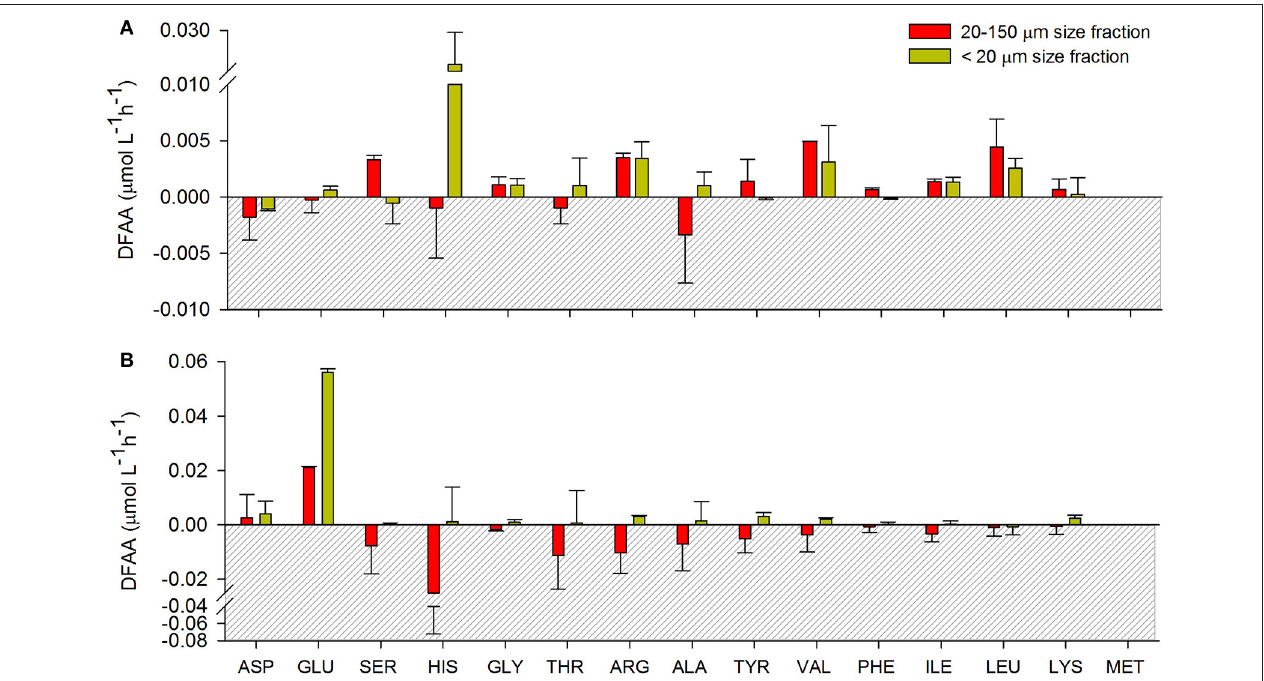
FIGURE 2 | Excretion rates obtained for aspartic acid (ASP), glutamic acid (GLU), serine (SER), histidine (HIS), glycine (GLY), threonine (THR), arginine (ARG), alanine (ALA), tyrosine (TYR), valine (VAL), phenylalanine (PHE), isoleucine (ILE), leucine (LEU), lysine (LYS), and methionine (MET) in (A) late summer and (B) spring for both treatments. Errors bars show the standard deviation ( n =